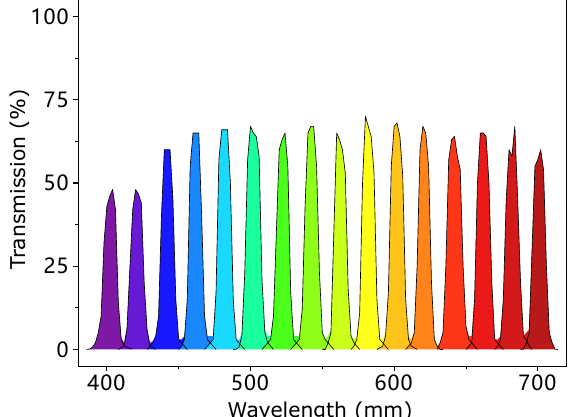
Figure 1. The transmission rate of 16